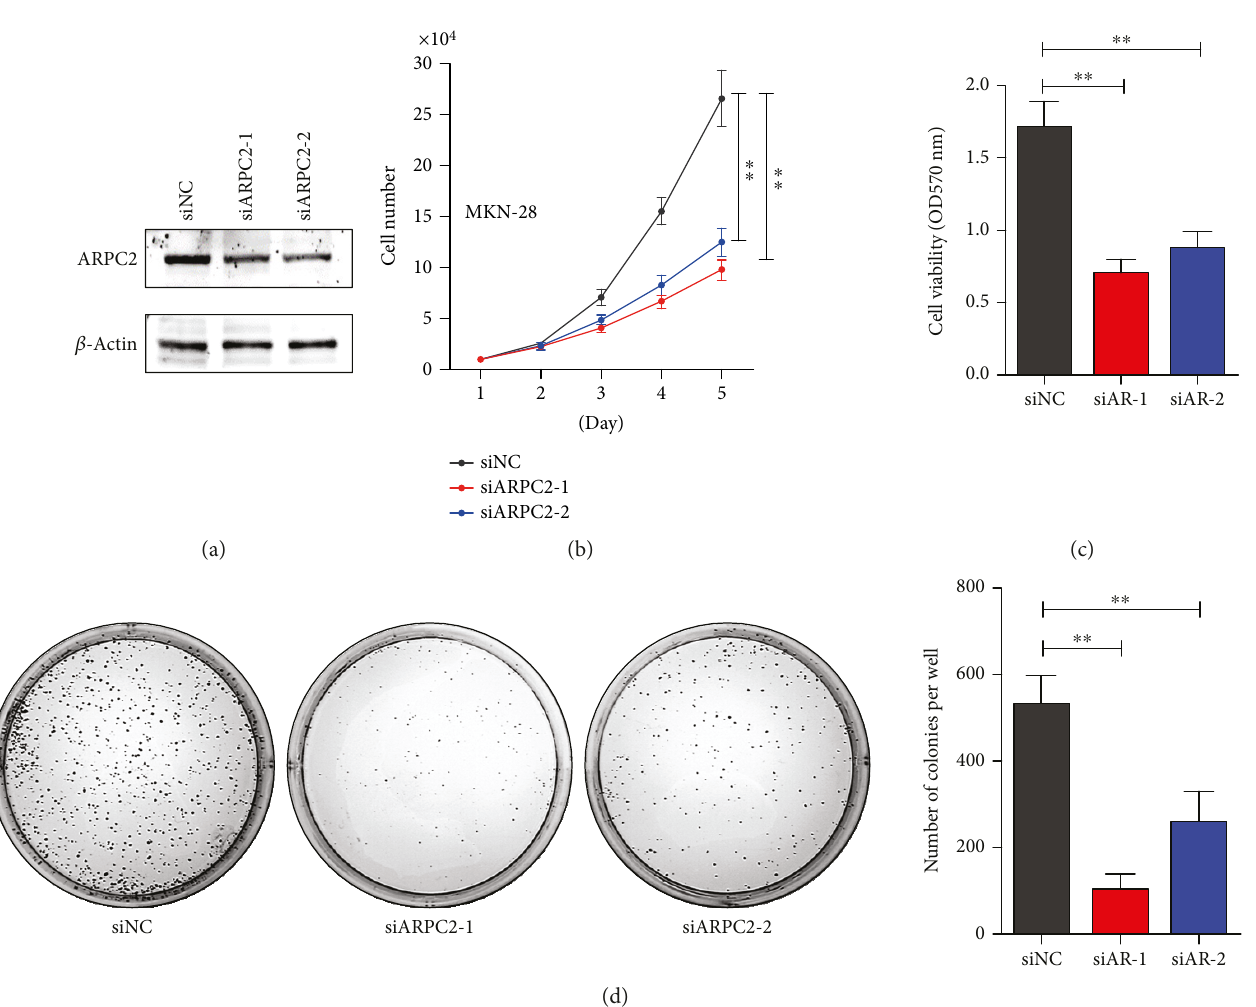
Figure 1: ARPC2 promoted proliferation of MKN-28 cells. MKN-28 cells were transfected with ARPC2-siRNA-1, ARPC2-siRNA-2, or negative control (siNC). (a) Protein level of ARPC2 was evaluated by western blot. (b) Cell total number assay; (c) MTT assay; and (d) cell colony formation assay were performed in MKN-28 cells after transfection. ∗ P < 0 05 . ∗∗ P < 0 01